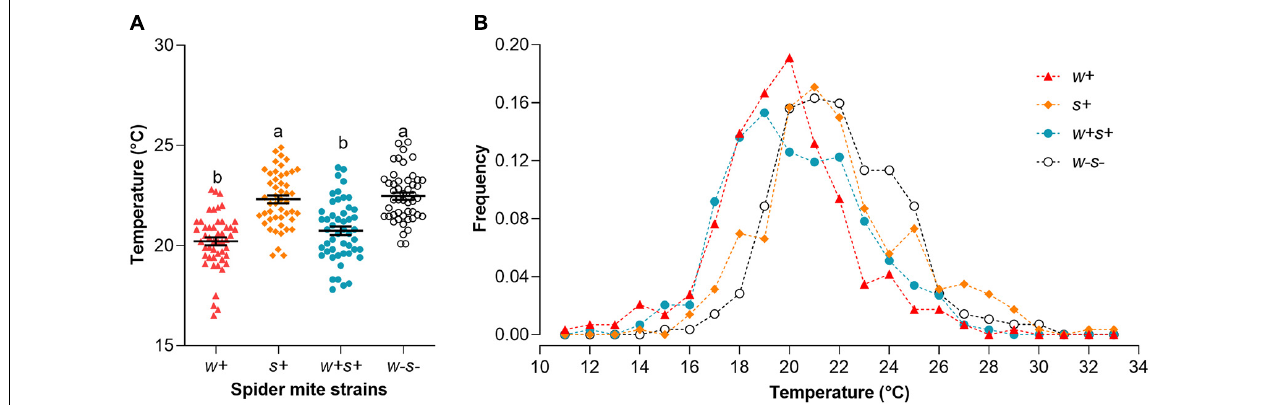
FIGURE 6 | Thermal preference (Tp) of the four spider mite strains. (A) Average Tp of the four spider mite strains. Each dot on the graph indicates the mean of six individuals in each replicate. Long bar indicates the mean of all dots in the strain, and error bars indicate SE. Different letters indicate significant differences between four spider mite strains ( p < 0.05). (B) Relative proportions of the four spider mite strains observed at a given